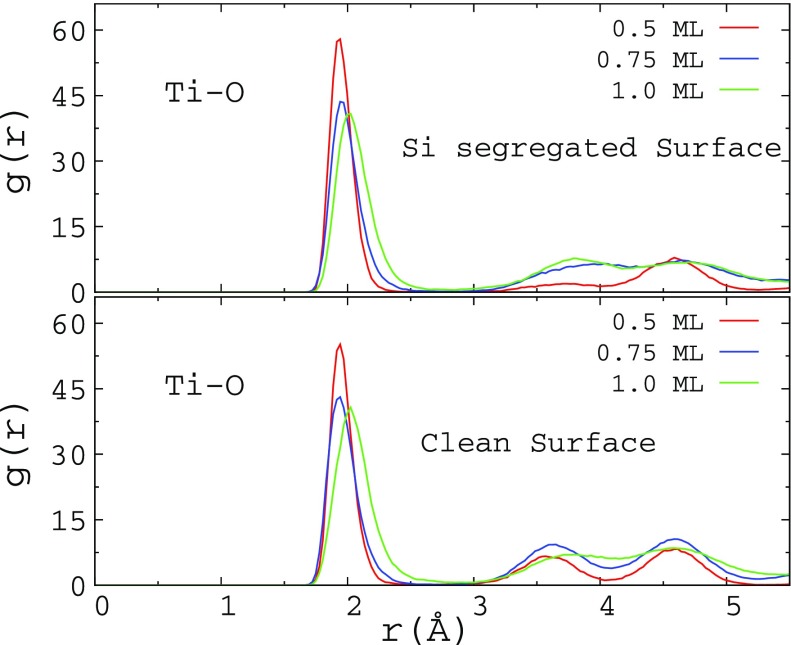
The radial distribution function (g(r)) for the clean and 18.75 at.% Si-segregated Ti(0 0 0 1) surfaces with different θ values at 973 K.